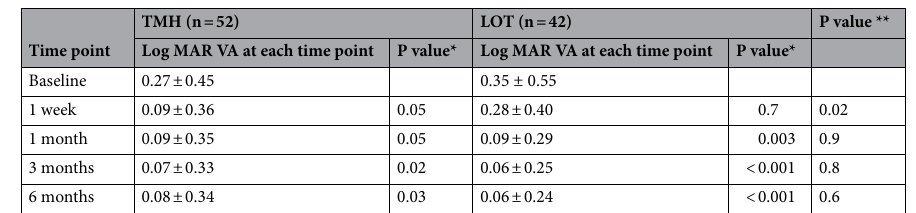
Table 2. Transition of visual acuity. Log MAR VA: logarithm minimal angle resolution. *Calculated using Dunnett’s test in IOPs between pre- and postoperative values. **Calculated using linear mixed model in Log MAR VA between TMH and